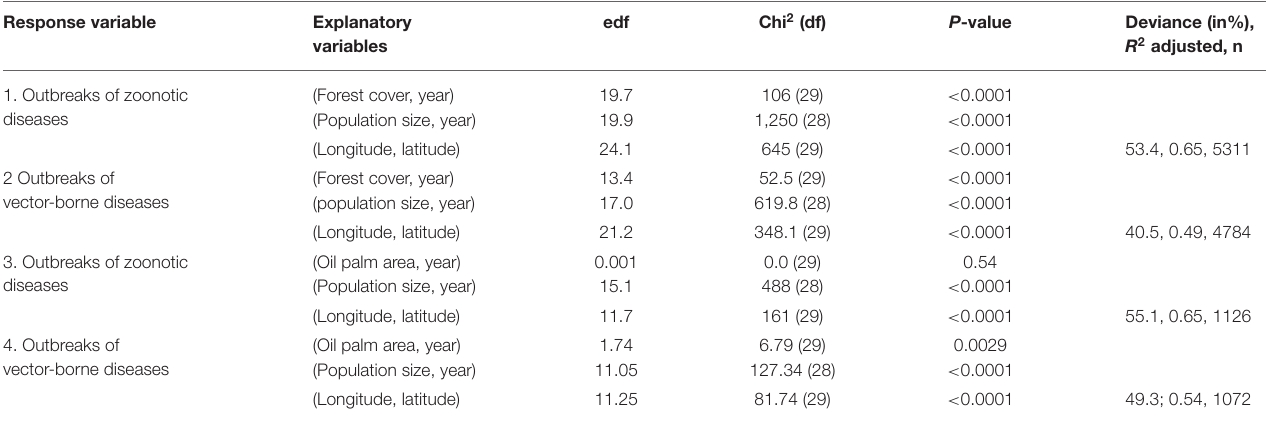
TABLE 1 | Results of general additive modeling (GAM) explaining the number of outbreaks of infectious diseases, zoonotic or vector-borne, per country and per year, with forest cover or oil palm areas, human population size and the matrix of longitude/latitude of country centroids as independent variables, using a negative binomial link and controlling for spatial and temporal effects, with approximate significance of smooth terms (edf, estimated residual degrees of freedom; df, degree of freedom) (see Methods for the models, data from GIDEON, FAOSTAT and World Bank) (see Figure 3